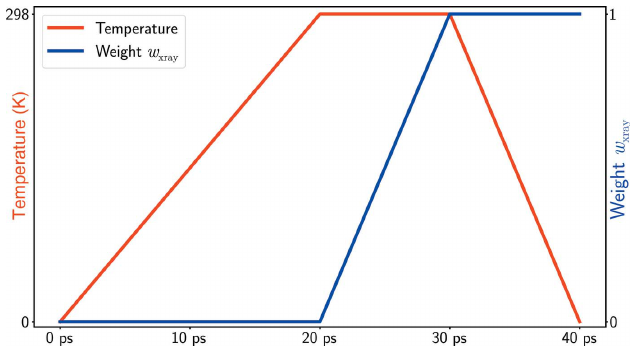
Figure 3 A schematic diagram of the Amber -based refinement protocol used in this work. This particular schedule has been developed through extensive experimentation and appears to be near-optimal for the goals of this